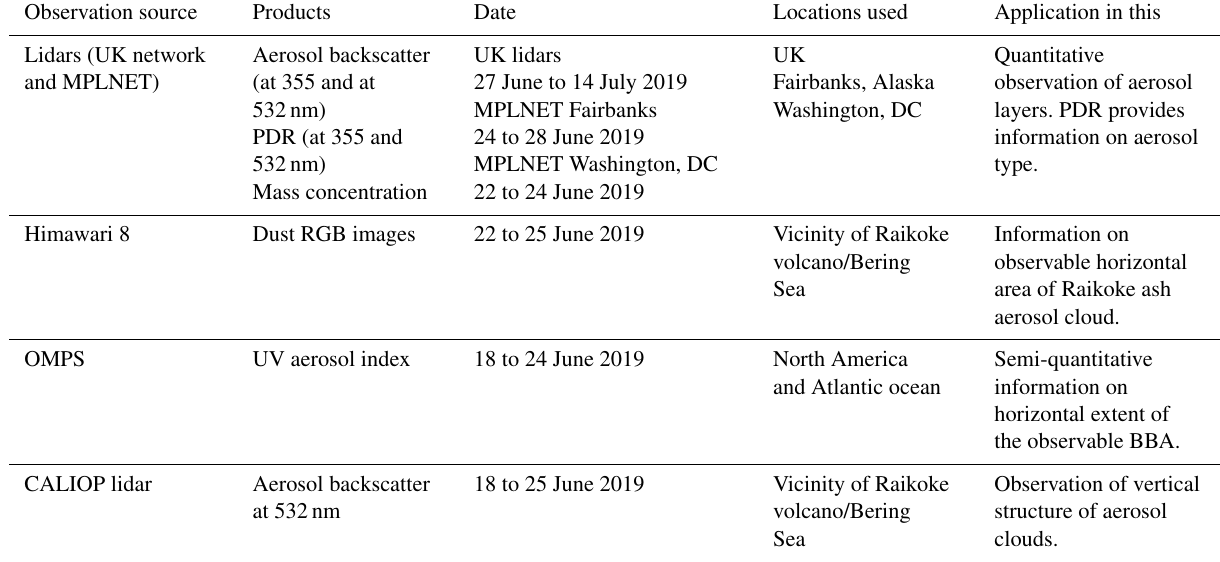
Table 2. Summary of observations.